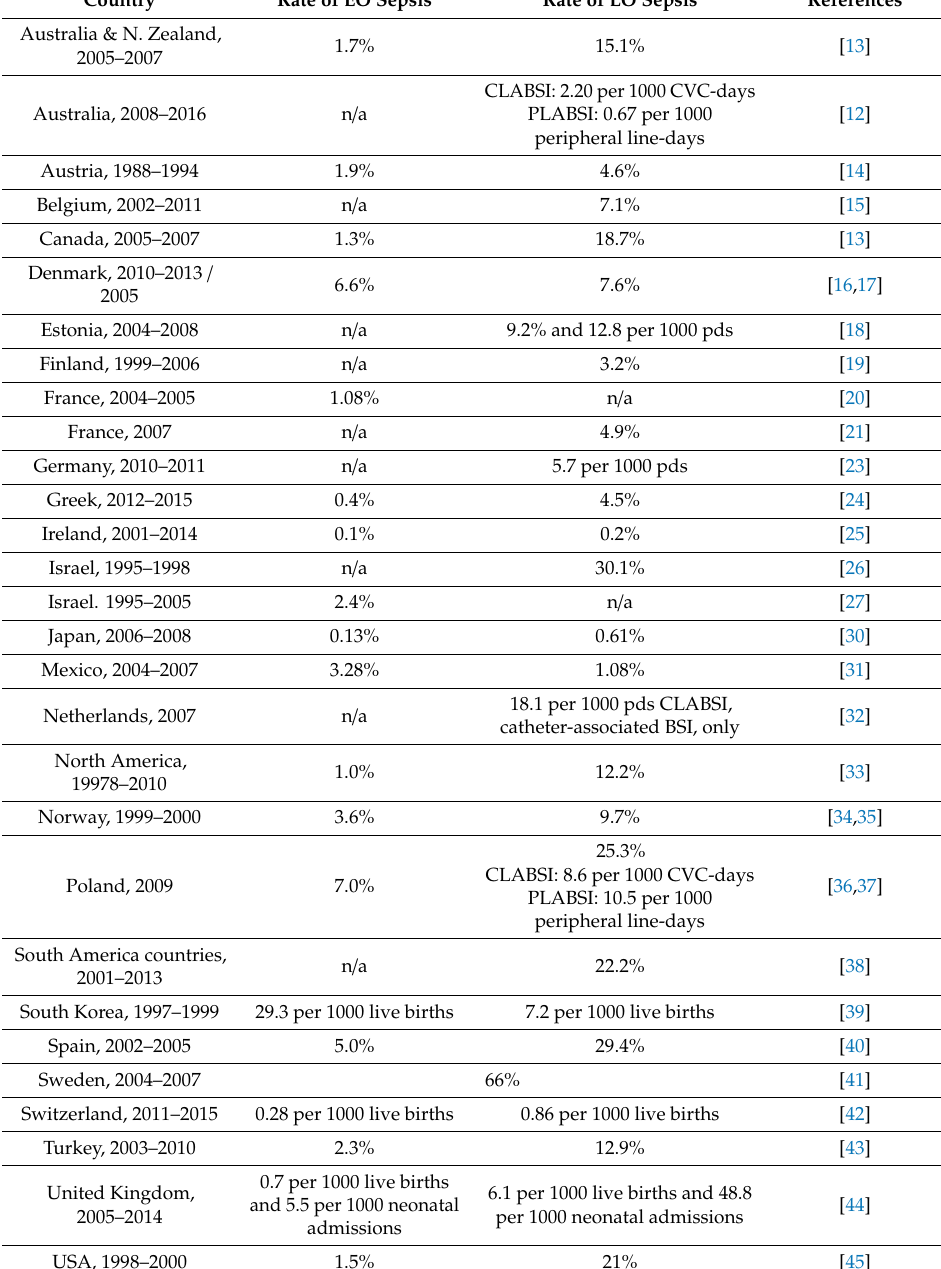
Table 2. Comparison of the early-onset (EO) versus late-onset sepsis (LO) / bloodstream infections incidence rate (in alphabetical order).